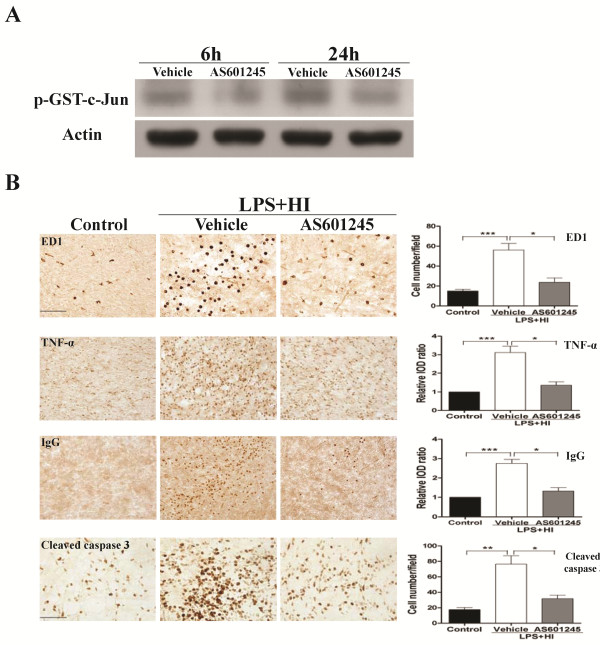
AS601245 significantly reduced neuroinflammation, blood–brain-barrier damage and cell apoptosis after lipopolysaccharide-sensitized hypoxic-ischemic white matter injury. (A) In vitro kinase assay of c-Jun N-terminal kinase (JNK) in the lipopolysaccharide (LPS) + hypoxic-ischemic (HI) group showed that AS601245 (40 mg/kg) effectively blocked JNK activity at 6 and 24 h post-insult compared with vehicle. (B) AS601245 (40 mg/kg) treatment (n = 8) significantly reduced upregulation of ED1-positive activated microglia, TNF-α immunoreactivities, IgG extravasation and cleaved caspase 3-positive cells in the white matter 24 h post-insult compared to vehicle (n = 7). Scale bar =100 μm for ED1, TNF-α and IgG; 50 μm for cleaved caspase 3. Values are means ± SEM. ***P <0.001, **P < 0.01, *P < 0.05.